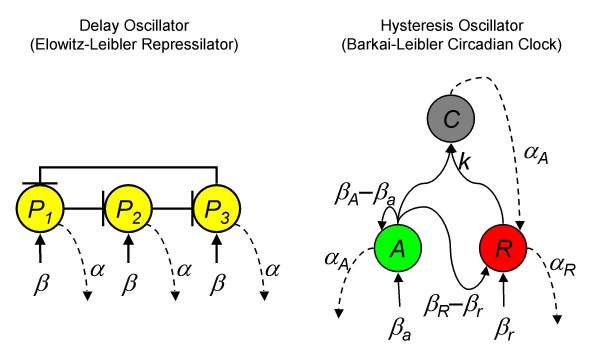
Schematic oscillator designs. (Left) The repressilator is a delay oscillator here idealized as three symmetric repressive components, P1, P2, and P3, with identical production rates, β, and decay rates, α. (Right) The hysteresis oscillator has interlocked feedback loops involving an activator, A, and a repressor, R, which form a complex, C, with a bimolecular rate constant k. The activator and repressor have baseline production rates βa and βa, with total production rising to βA and βR when the concentration of free activator is high. The activator degrades at rate αA whether free or complexed; the repressor degrades at rate αR but only when free.